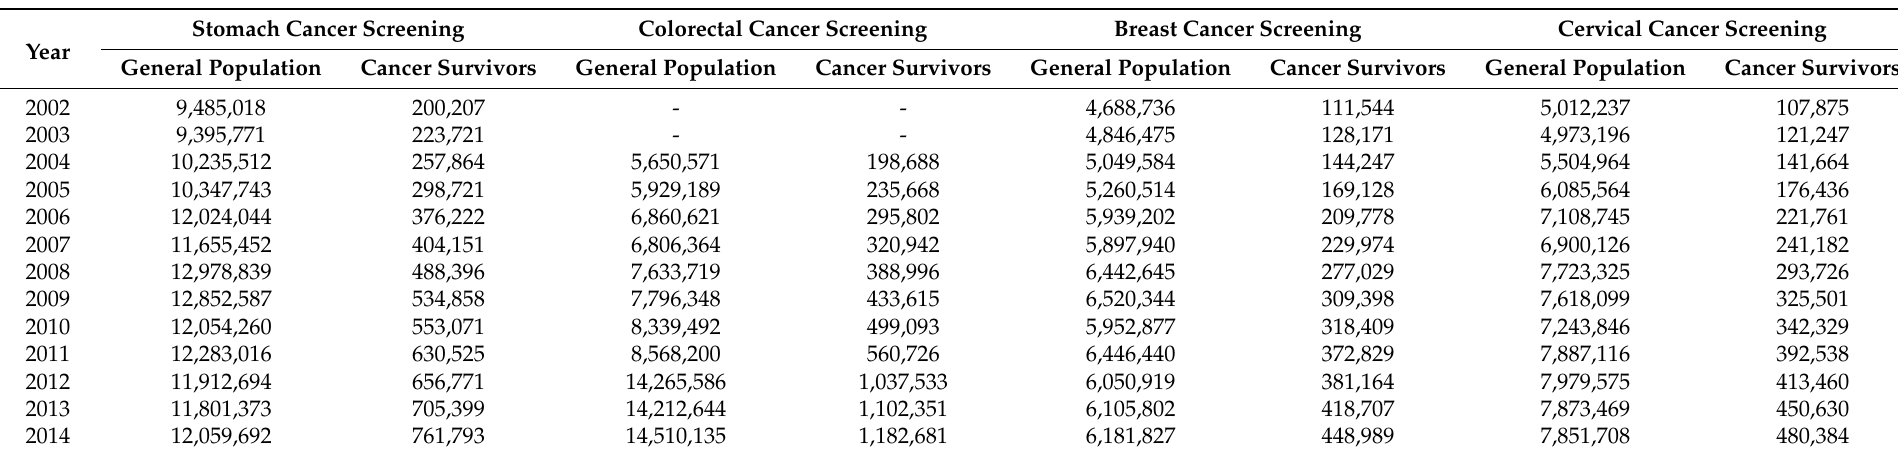
Table 1. Target population size of the National Cancer Screening Program (NCSP) by the general population and cancer survivors.